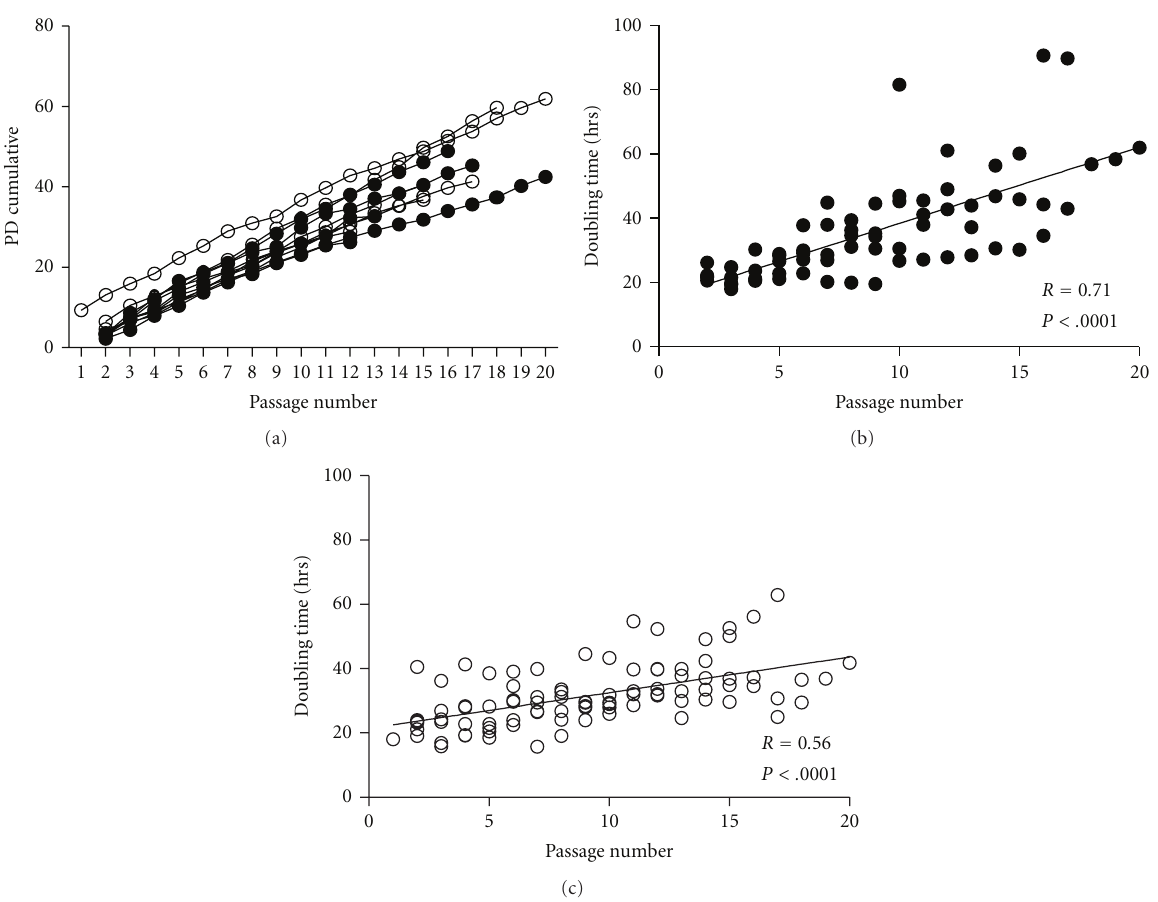
Figure 2: The growth kinetics of DPSC lines. (a) Cumulative population doublings of 11 DPSCs lines are shown. The cultures were derived from individual patients and passaged as described in Section 2. The number of population doublings was calculated as follows: PD = (log 10 n f − log 10 n i )/0.301, where n i is the initial number of cells and n f is the final number of cells at each passage. (b, c) Data of doubling time reached by DPSCs from male (b) and female (c) donors at di ff erent passages in culture. The linear regression line best fitting the data is shown, R = 0 . 71, P < . 0001. The doubling time was calculated from the formula DT = log 10 2 T /log 10 n f − log 10 n i , where T is time in hrs. R = 0 . 56, P < . 0001. Filled circles indicate males and open circles indicate females.